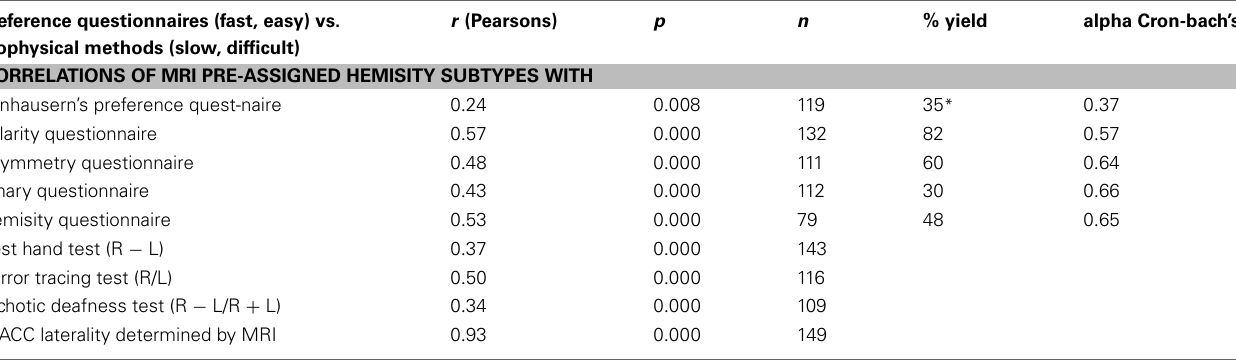
Table 2 | Overall correlations and reliability of preference questionnaire scores with predetermined subject hemisity subtype. Preference questionnaires (fast, easy)